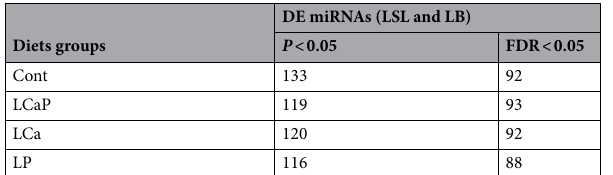
Table 1. The number of differentially expressed (DE) miRNAs between strains (Lohmann Selected Leghorn (LSL) and Lohmann Brown (LB)) within diet groups at cut-offs of P < 0.05 and FDR < 0.05.